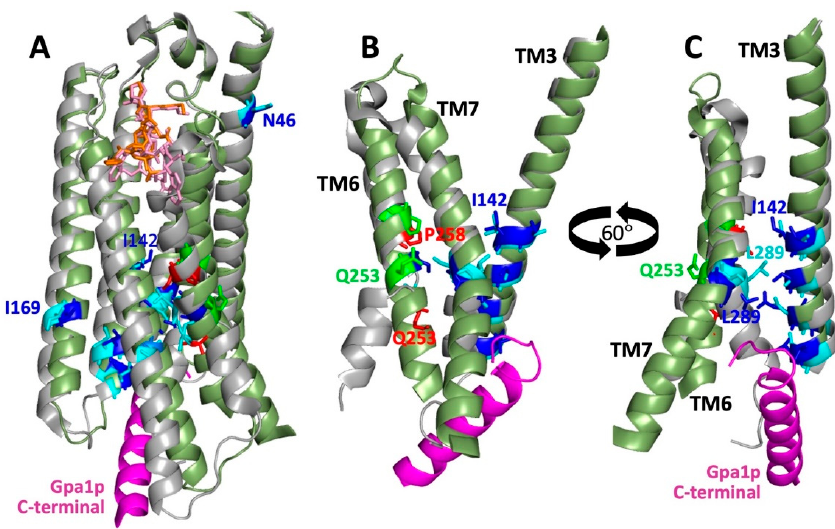
Figure 8. Locations of constitutively activating mutations in the structure of Ste2p (See Table 1). The aligned structures of antagonist- and agonist-bound Ste2p (PDB codes 7QA8 and 7AD3) are colored grey and olive green, respectively. Sites of the three strongest identified constitutive mutations, P258, Q253, and S259, [79–81] are shown in stick representations in red for the antagonist-bound structure, and in bright green for the agonist-bound structure. Other constitutive mutations listed in Table 1 are shown in stick representations in cyan for the antagonist-bound structure, and in dark blue for the agonist-bound structure. The C-terminal region of Gpa1p is shown in magenta. Panel ( A ) shows the entire Ste2p monomer with bound antagonist ([desTrp 1 Ala 3 Nle 12 ] α -factor) shown in stick representation in orange, and bound agonist ( α -factor) shown in pink. Panels ( B ) and ( C ) are two views, rotated 60 ◦ with respect to each other, showing just the sites of constitutive mutations on TM3, TM6, and